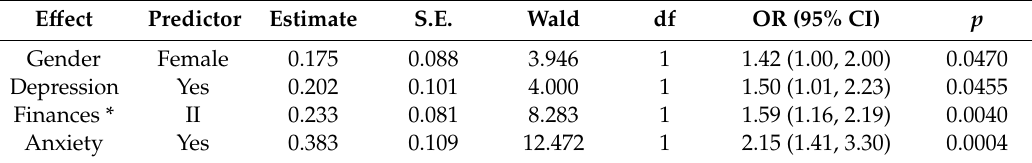
Table 11. Prediction of awake bruxism (AB) in Israel.